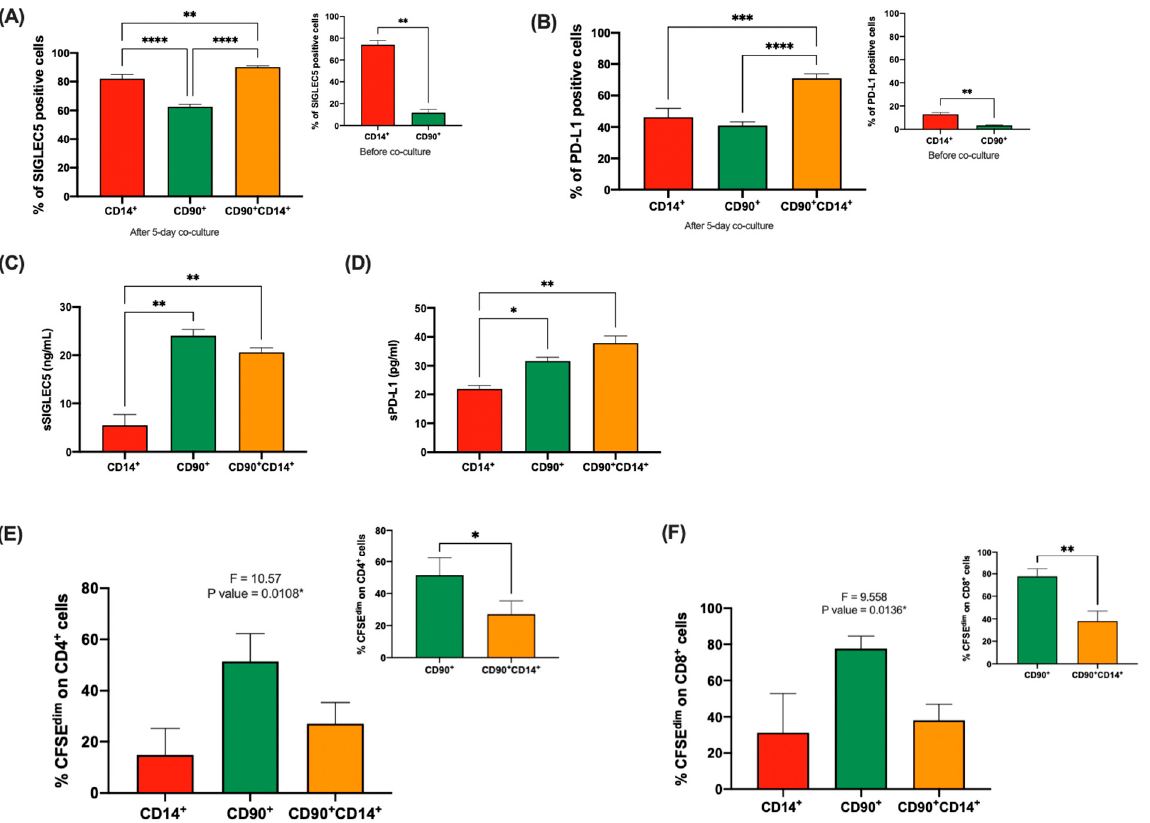
Figure 3. Immunomodulatory properties of novel-resulted FHCs after co-culture. ( A ), Analysis of SIGLEC5 expression on CD14 + human monocytes (red), CD90 + hADMSCs (green), and CD90 + CD14 + FHCs (tangerine) after 5-day co-culture by FACS (n = 9). (Insert), Analysis of SIGLEC5 expression on CD14 + human monocytes (red) and CD90 + hADMSCs (green) before co-culture by FACS. **, p < 0.01; ***, p < 0.001; ****, p < 0.0001 in one-way ANOVA with Tukey’s multiple comparison post-hoc test and **, p < 0.01 in Mann–Whitney test, respectively. ( B ), Analysis of PD-L1 expression on CD14 + human monocytes (red), CD90 + hADMSCs (green), and CD90 + CD14 + FHCs (tangerine) after 5-day co-culture by FACS. (Insert), Analysis of PD-L1 expression on CD14 + human monocytes (red) and CD90 + hADMSCs (green) before co-culture by FACS. **, p < 0.01; ***, p < 0.001; ****, p < 0.0001 in ordinary one-way ANOVA with Tukey’s multiple comparison post-hoc test and **, p < 0.01 in